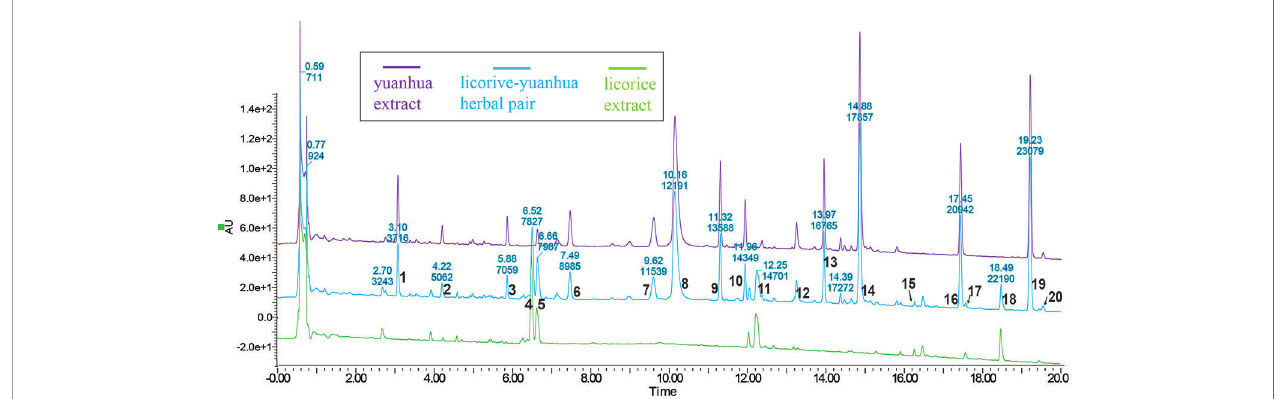
FIGURE 2 | UPLC pro fi les of licorice, yuanhua, and the licorice-yuanhua herbal pair. Wavelength of UV-detector was set at 254 nm, and most peaks appear within 20 mins. These compound peaks were identi fi ed by the UPLC-TOF-MS method: 1, phenolic acid (possibly Neochlorogenic acid, 3- O -Caffeoylquinic acid or 5- O - Caffeolyquinic acid); 2, Cinnamic acid; 3, Luteolin-5- O -glucoside; 4, Liquiritin/Isoliquiritin; 5, overlapping of Liquiritin/Isoliquiritin apioside (from licorice) and Apigenin 6- C -glucoside-8- C -arabinoside (from yuanhua); 6, fl avonoid glycoside (possibly Apigenin 5- b -D-glucopyranoside, Apigenin-6- C -glucoside, or Apigenin 7- O - b -D- glucopyranoside); 7, Leucanthoside or 3 ’ -Hydroxygenkwanin 5- O - b -D-glucoside; 8, mix of Magnesium pheophytin and Apigenin-7- O - b -D glucuronoside; 9, fl avonoid glycoside (possibly Apigenin 7-rhamnoglucoside, Kaempferitrin, 4 ’ ,5-dihydroxy-7-methoxy-5-( O -xyloglucoside)- fl avone, Genkwanin 5- O - b -D-primeveroside, or Yuenkanin); 10, Genkwanin 5- O - b -D-glucoside; 11, fl avonoid (possibly Liquiritigenin, Isoliquiritigenin, or Pinocembrin); 12, Luteoline; 13, Tiliroside; 14, Apigenin; 15, 22-Acetoxyl-glycyrrhizin; 16, Hydroxygenkwanin; 17, triterpenoid saponin (possibly Yunganoside K2, Licorice saponin G2, or 22-Hydroxy-glycyrrhizin); 18, Glycyrrhizin; 19, Genkwanin; 20, triterpenoid saponin (possibly Licorice saponin H2/K2, 18 a -Glycyrrhizin, Uralsaponin B, or Yunganoside L2/J2). The UPLC-TOF-MS pro fi les of licorice and yuanhua are given in the supplementary information, and the complete lists of identi fi cation compounds are also provided ( Supplementary Figures S1 and S2 and Tables S1 and S2